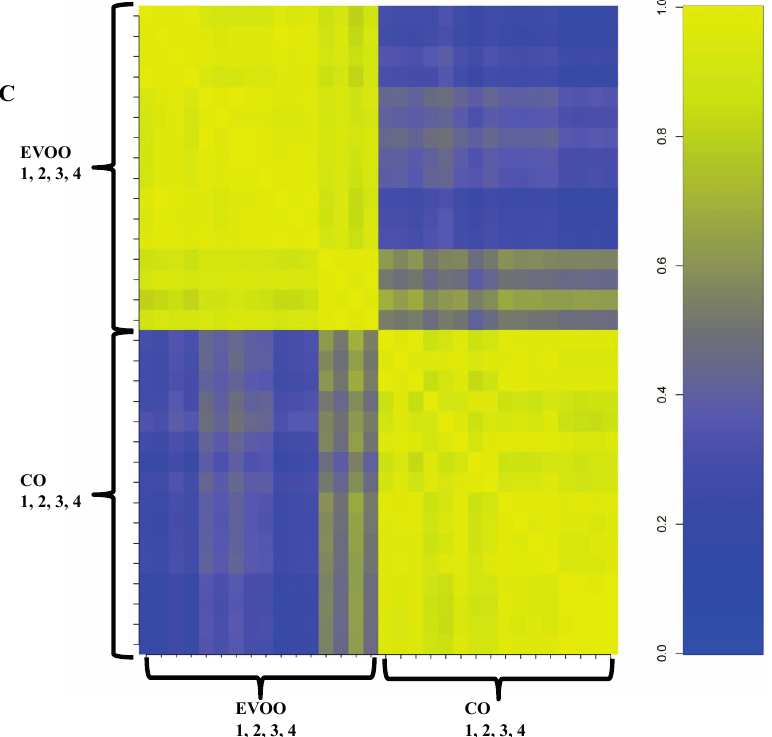
Figure 2. Data analysis of independent MALDI-TOF MS lipid spectra profiles of EVOO and CO. ( A ) Shows the 3D scatter plot image from the PCA analysis obtained by Biotyper software for EVOO and CO samples; ( B ) Shows the UHC tree (bootstrap n = 1000) generated by pvclust of each EVOO, and CO sample, and their replicates. Values on the edges of the clustering are p -values (%). Red values are AU (Approximately Unbiased) p -values, and green values are BP (Bootstrap Probability) values, as explained in experimental section; ( C ) Shows Pearson’s correlation coefficients represented as a correlation matrix of e EVOO and CO samples and their replicates. The correlation coefficients have been colored according to a scale ranging from 0 to 1, where blue corresponds to 0 and yellow to